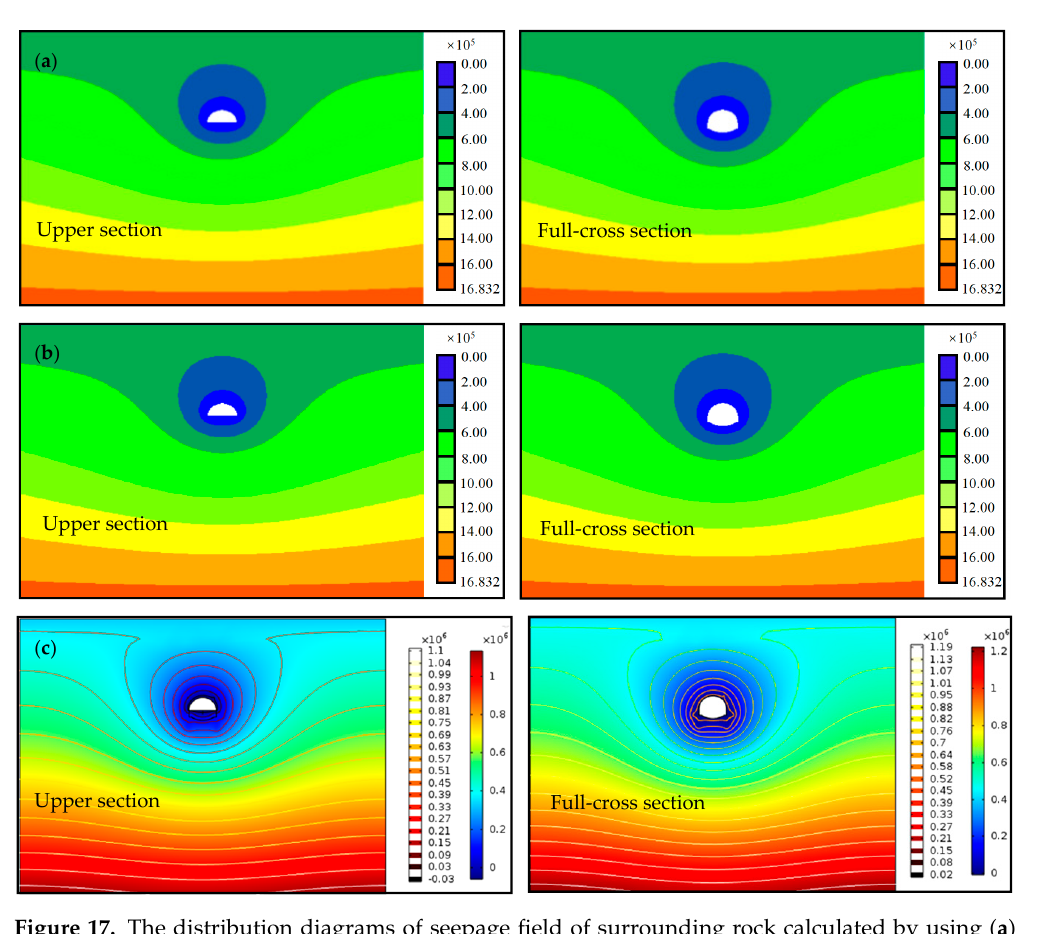
Figure 18. The compared diagrams of water inflow in the subsea tunnel. ( a ) upper section and ( b ) full-cross section